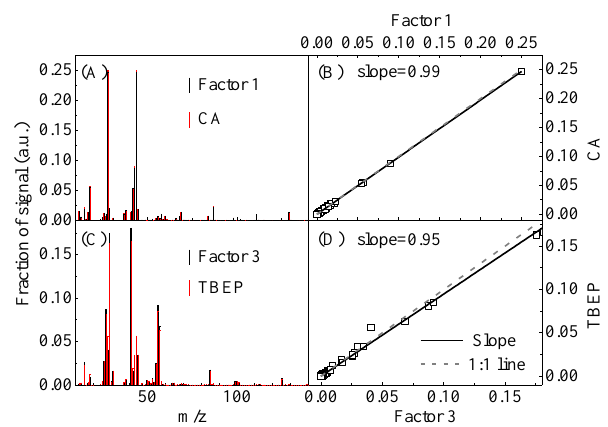
Figure 3. Comparison of the mass spectra extracted by PMF analy- sis and those measured through direct